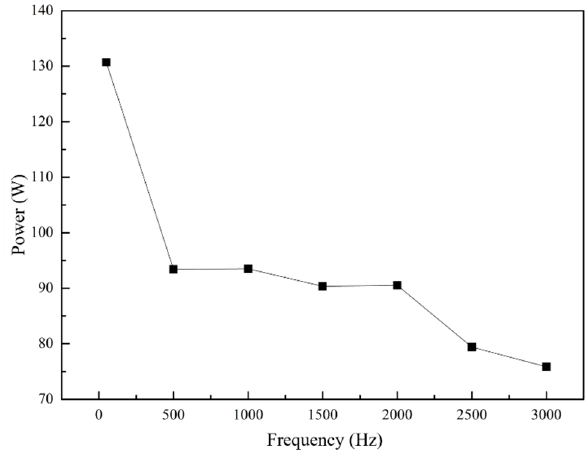
Figure 14. Relationship between power and electric field frequency.